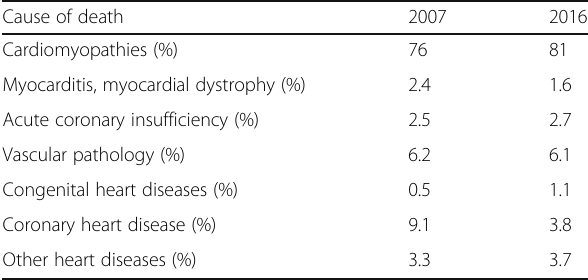
Table 3 Statistics for the causes of SCD in young people